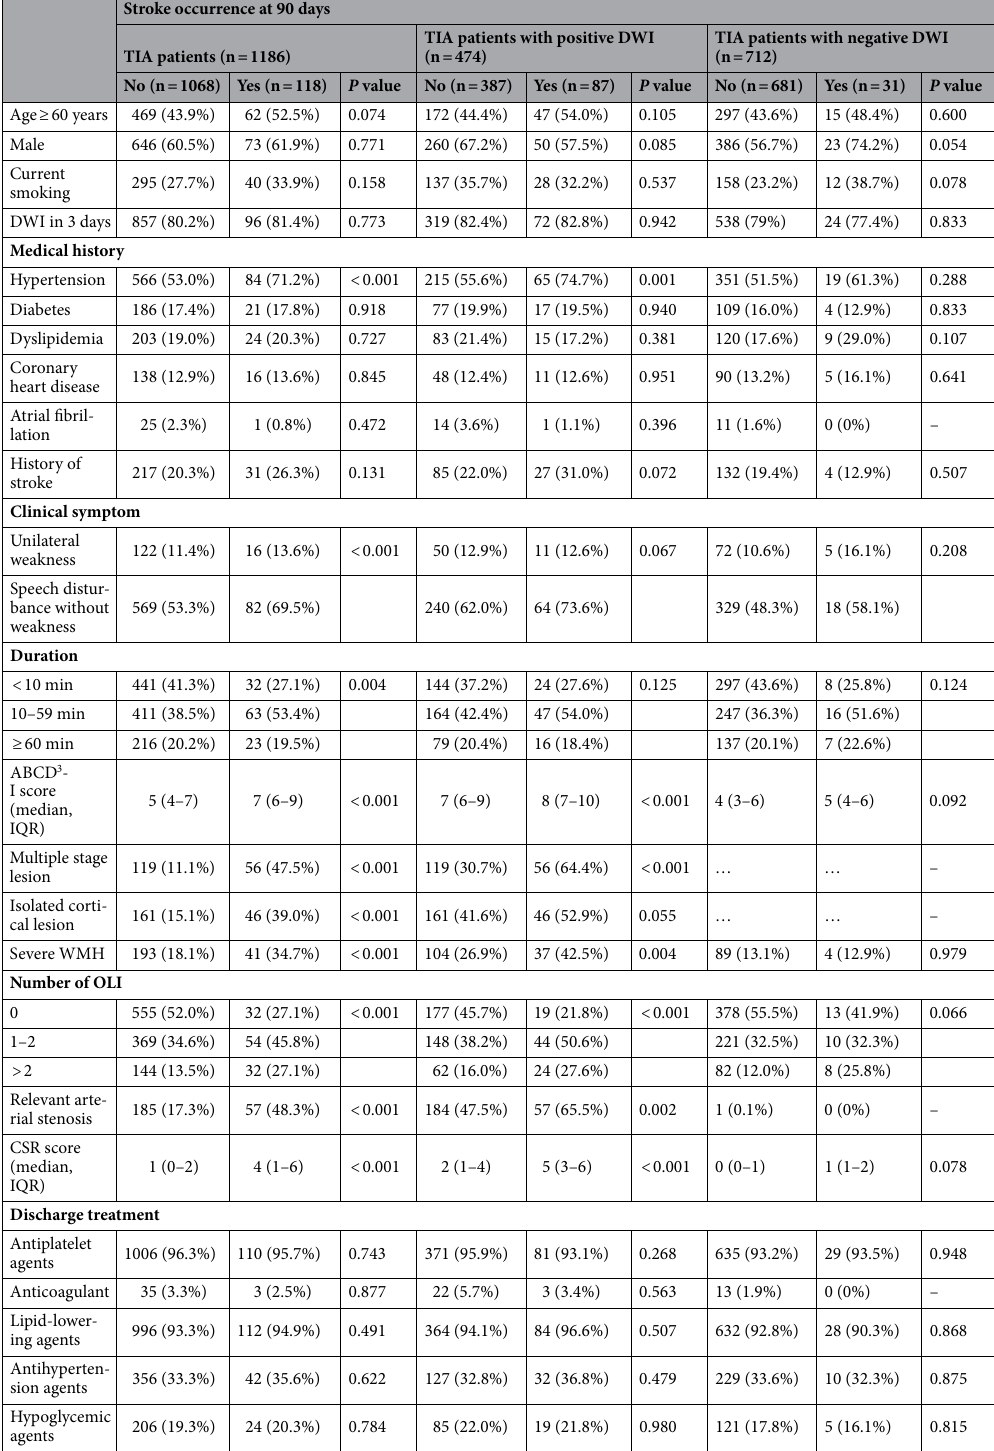
Table 3. Baseline characteristics and risk factors of patients with and without recurrence at 90 days. Statistical analysis not possible owing to absence of events in the group of TIA patients with negative DWI. TIA transient ischemic attack, DWI diffusion-weighted imaging, CSR comprehensive stroke recurrence, OLI old lacunar